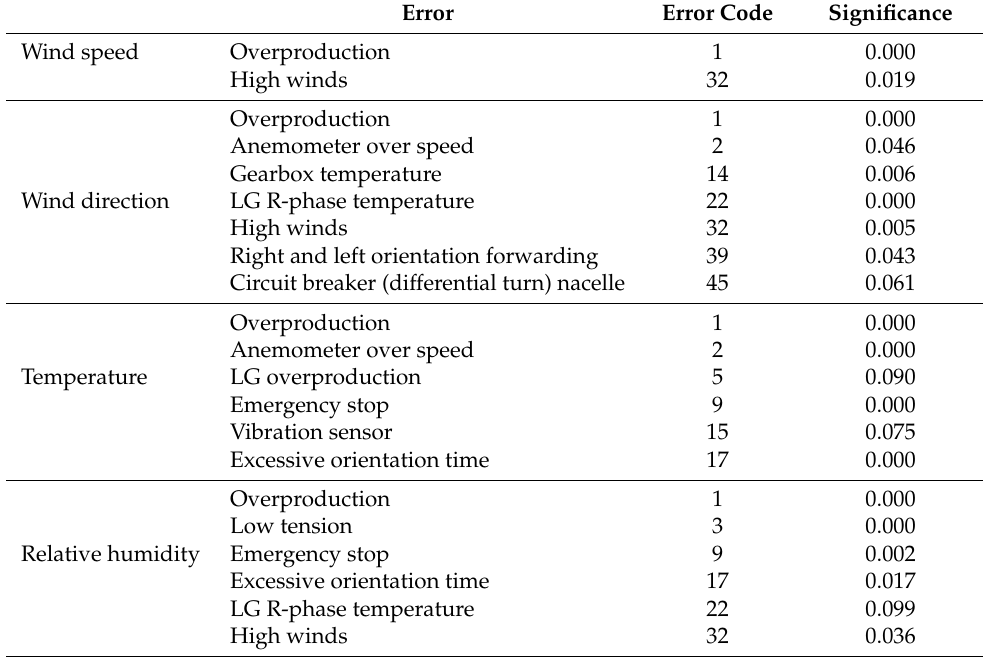
Table 5. Analysis of the significance of each failure condition for each different climatic